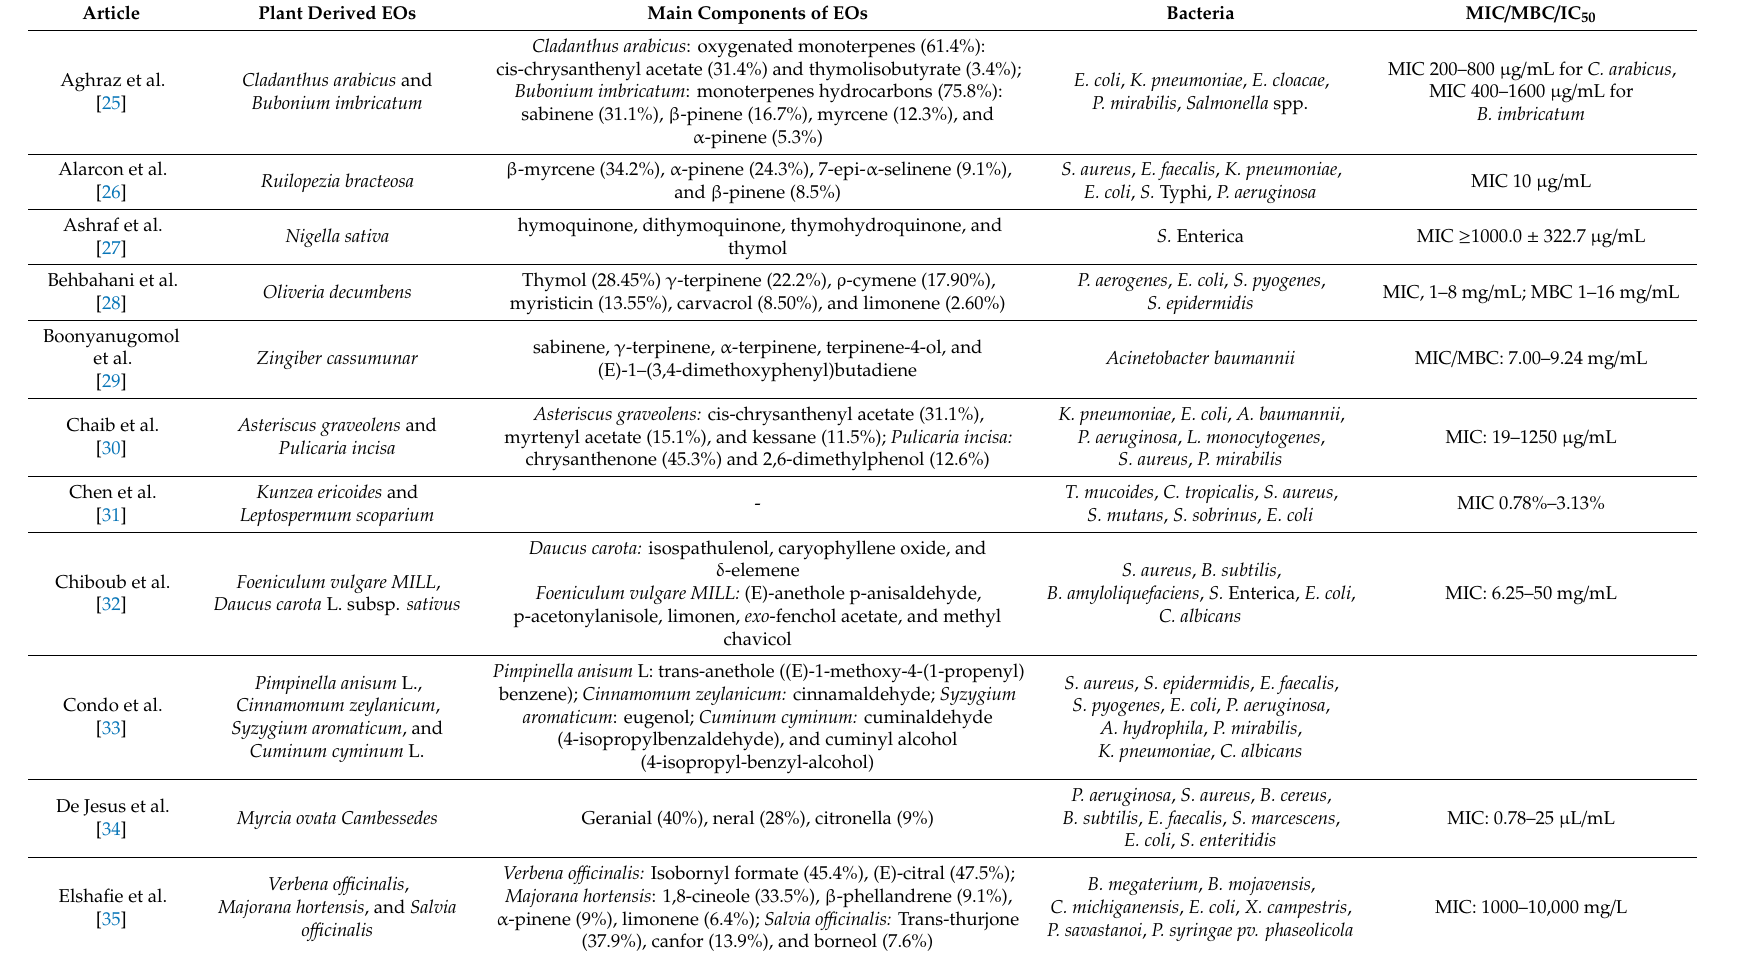
Table 2. Main characteristics of studies related with antibacterial properties of essential